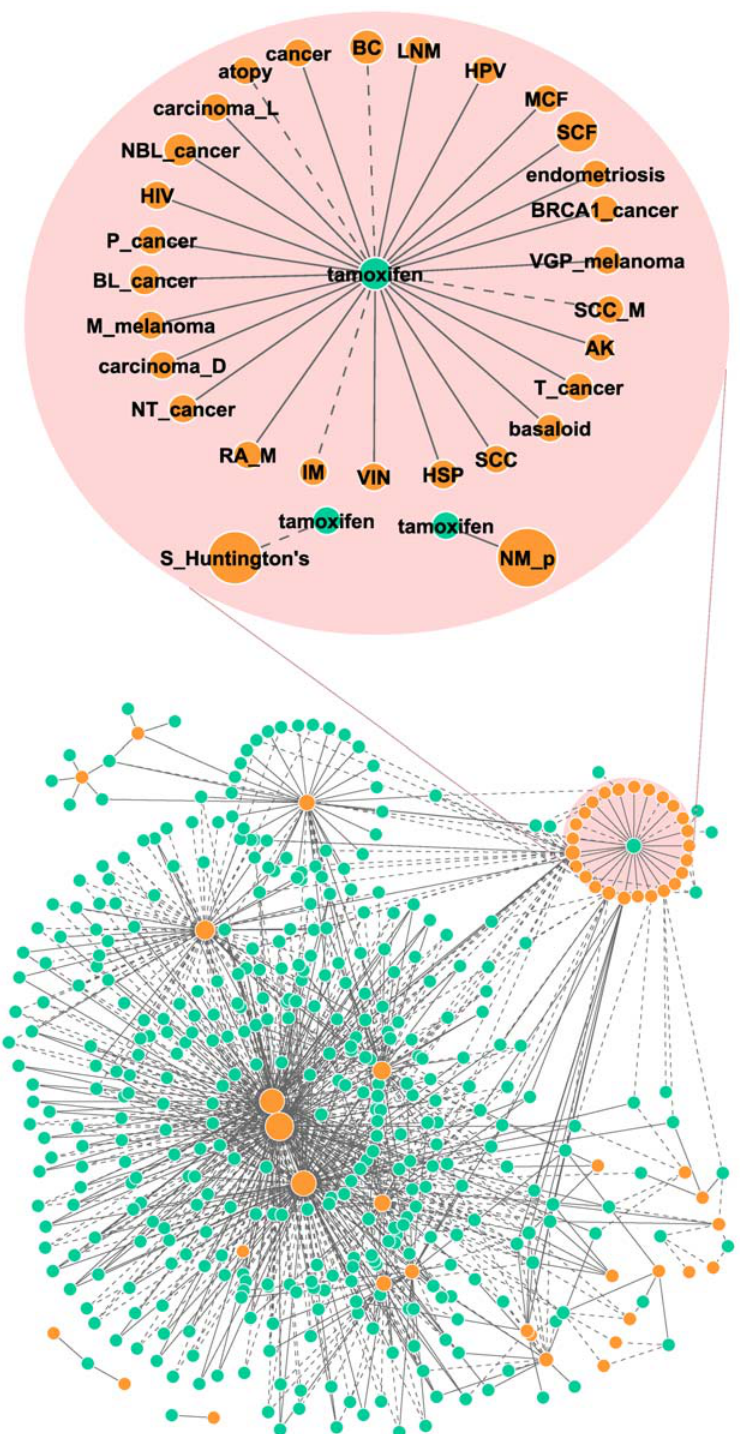
Figure 2. Disease-drug network. This disease-drug network contains a total of 49 diseases in dark cyan nodes, 213 drugs in gold, and 906 connections. The size of the nodes is proportional to the number of links. Positive matches are shown by solid lines and negative relationships by dotted lines. Multiple nodes with the same descriptive name exist because the corresponding profiles were generated under different conditions or studies (refer to Supplementary Table S7 online for details). In addition to the abbreviations listed in the Figure 1 legend, other abbreviations used in this figure include: AK, actinic keratosis; BC, breast cancer; BL_cancer, basal_like cancer; BRCA1_cancer, BRAC1-associated cancer; HPV, human papillomavirus; IM, idiopathic myelofibrosis; LNM, lymph node metastasis; MCF, mild cystic fibrosis; NBL_cancer, non-basal-like cancer; NT_cancer, non-tumorigenic cancer cell; P_cancer, metastatic prostate cancer; RA_M, rheumatoid arthritis on methotrexate; SCC, squamous cell carcinoma; SCC_M, squamous cell carcinomas (lymph node metastasis); SCF, severe cystic fibrosis; T_cancer, tumorigenic cancer cell; VGP_melanoma, vertical growth phase melanoma; VIN, vulvar intraepithelial neoplasia.